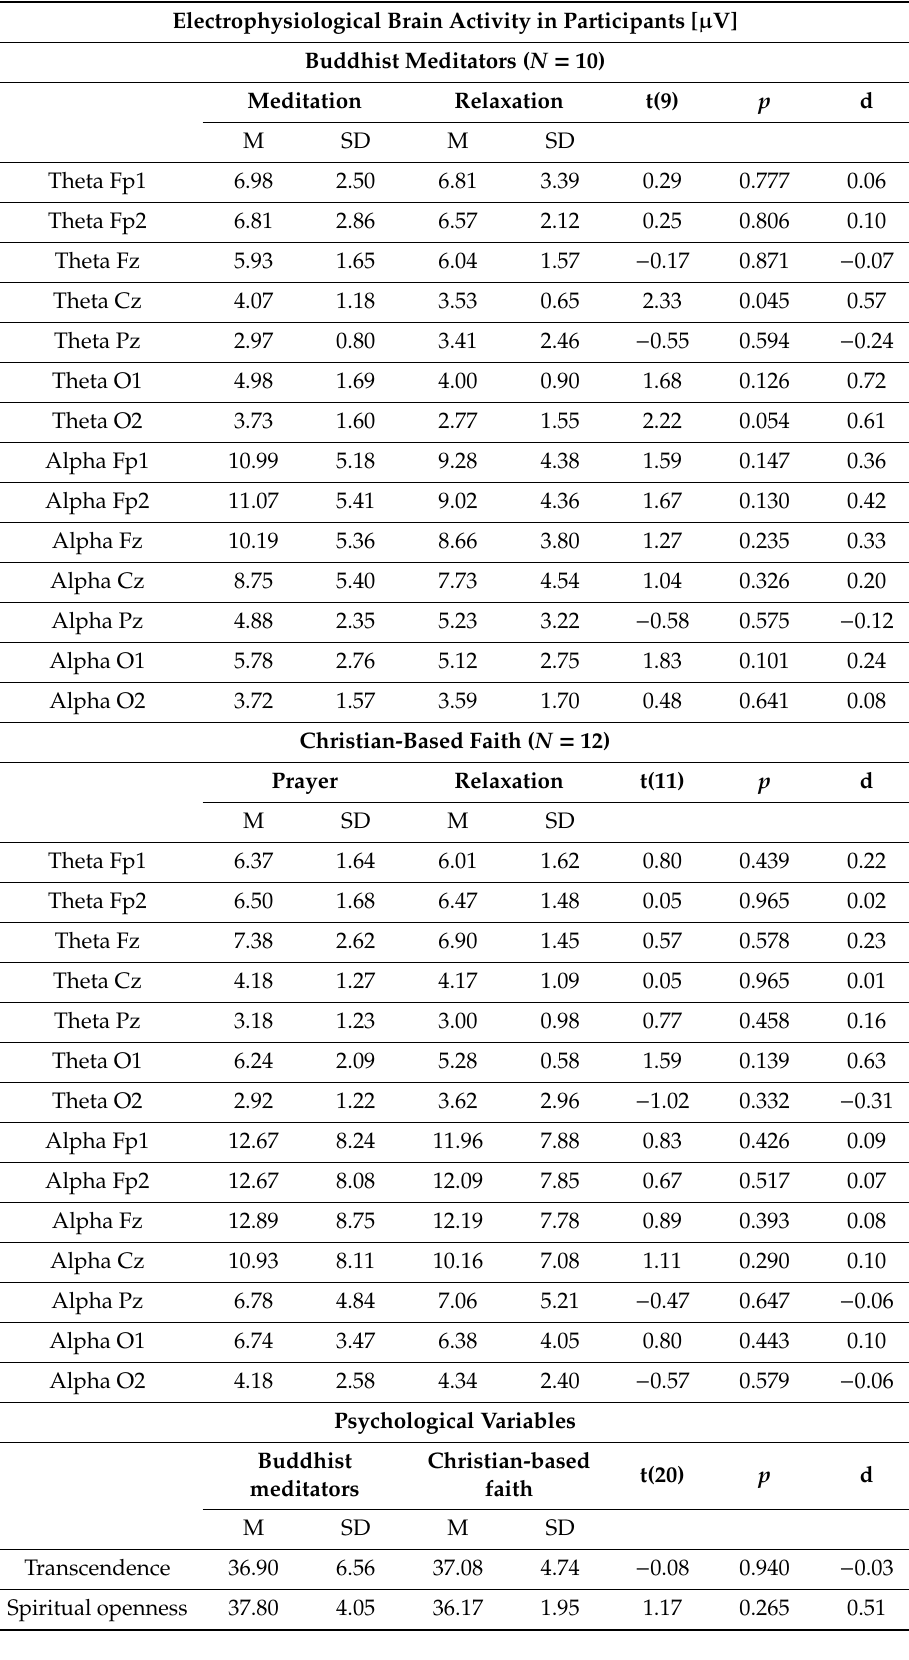
Table 1. Mean values regarding EEG, transcendence, and spiritual openness in participants. Electrophysiological Brain Activity in Participants [ µ V] Buddhist Meditators ( N = 10) Meditation Relaxation